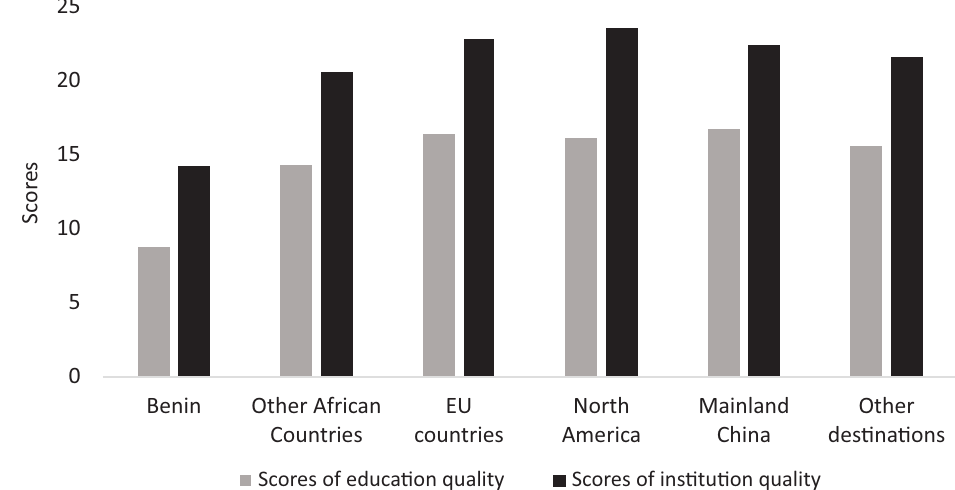
Figure 2. The average scores of institutions and the quality of the